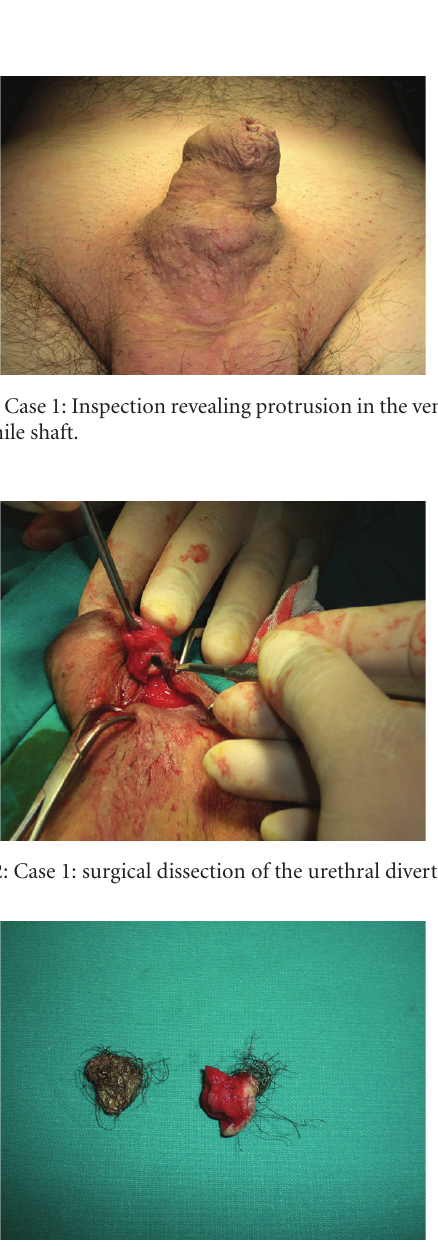
Figure 3: Case 1: removed diverticulum with stone and hairs.